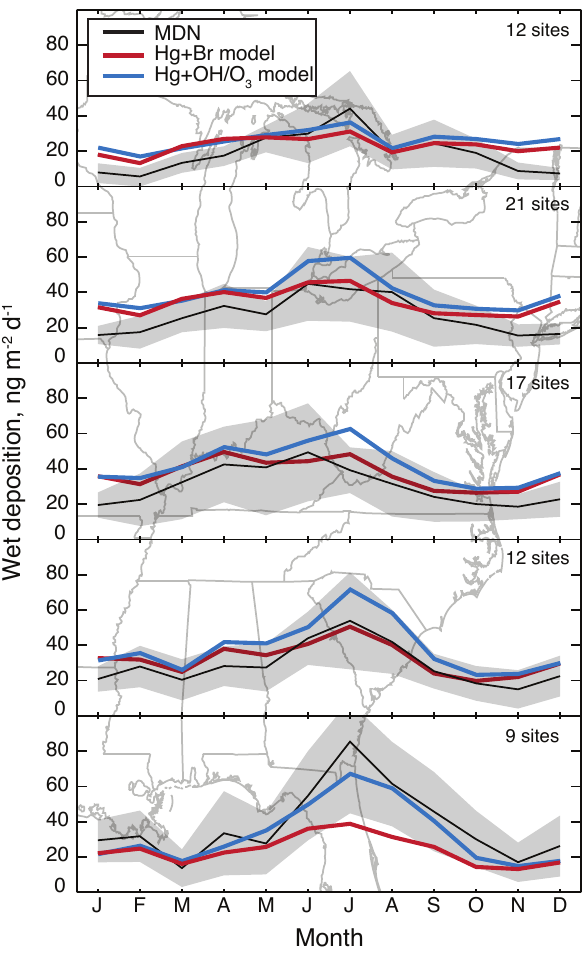
Fig. 10. Mean seasonal variation of mercury wet deposition to the Eastern United States for 2006–2008. Observations include all MDN sites within each depicted region with more than 21 days of data per month; black lines are means with ± standard deviations shaded. Insets list the number of MDN sites. Model results are averaged over each of the 4 ◦ × 20 ◦ regions